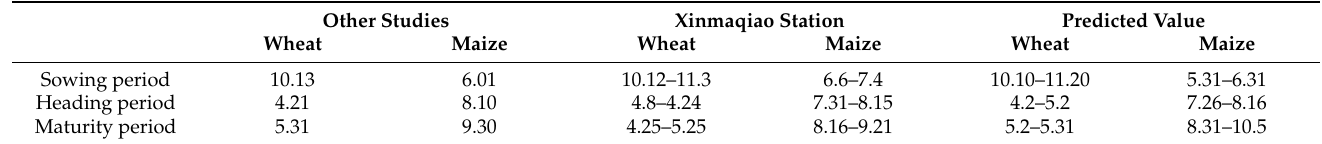
Table 4. Statistics of crop phenological periods.